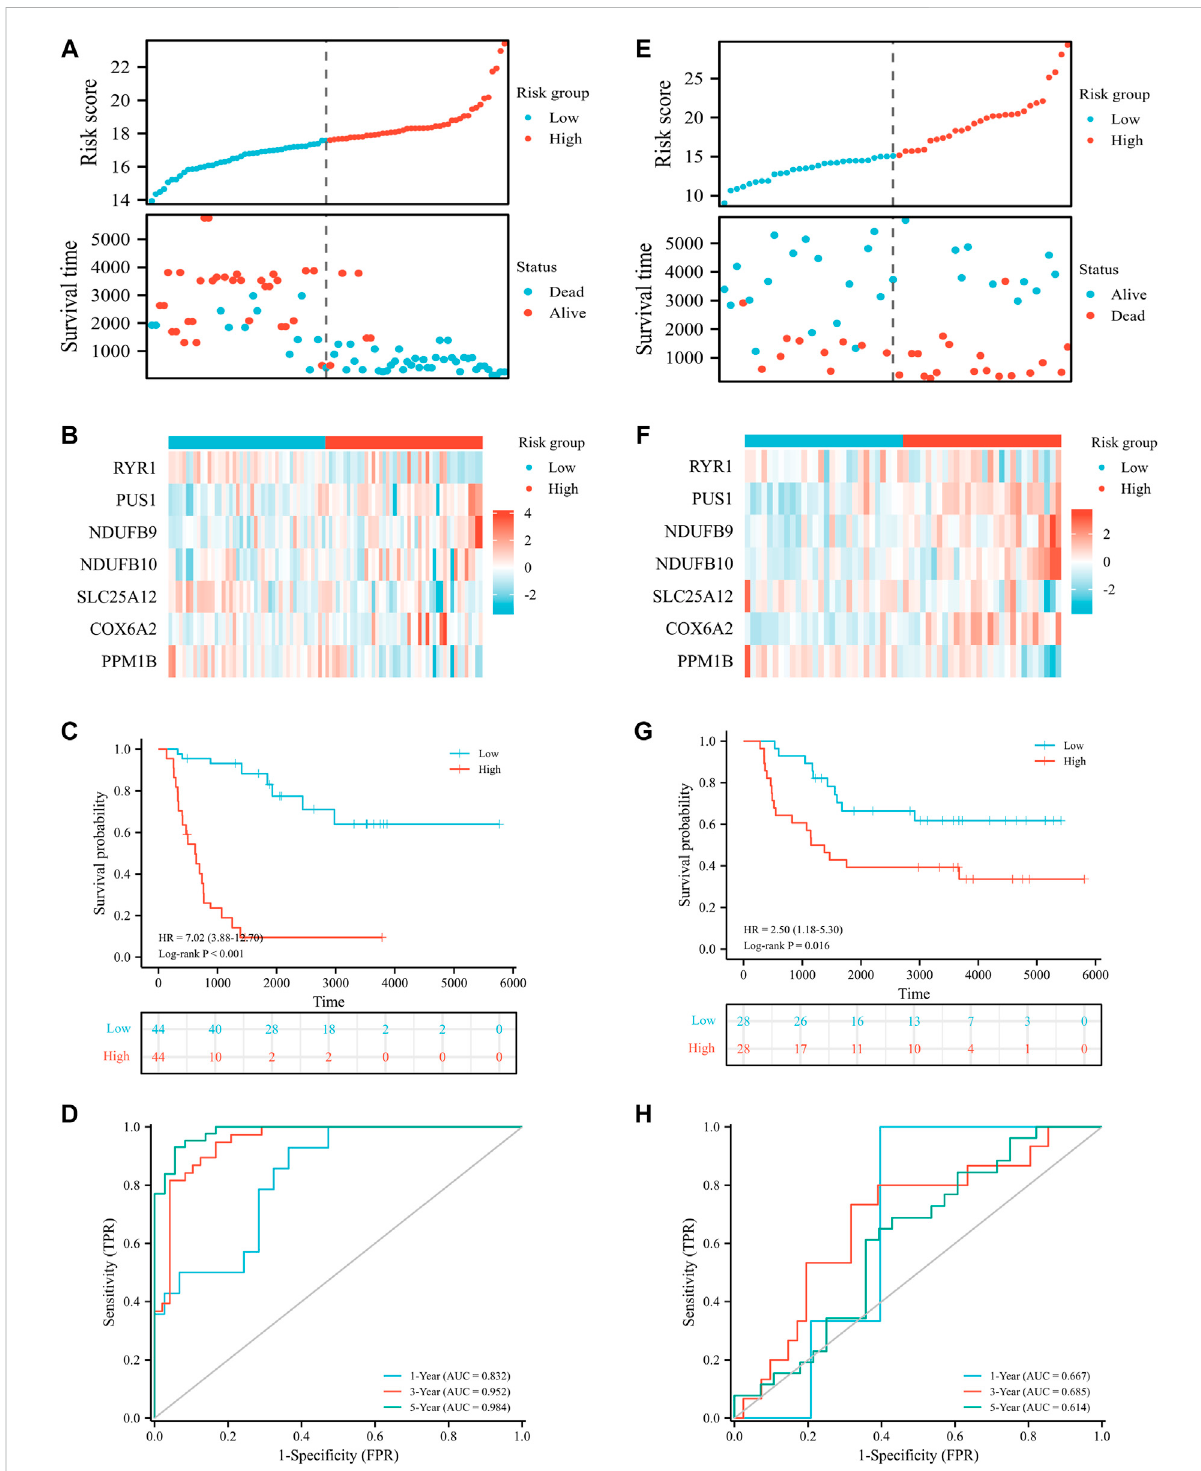
FIGURE 6 PrognosticvalueofLRGssignatureinEWSpatients.Distributionplotsoftheriskscoreandsurvivalstatusinthetraining (A) andvalidationcohort (E) ; Heat map showing the expression of candidate genes for different risk groups in the training (B) and validation cohort (F) ; The survival analysis in the training (C) and validation cohort (G) ; The ROC curve for the training (D) and validation cohort (H)